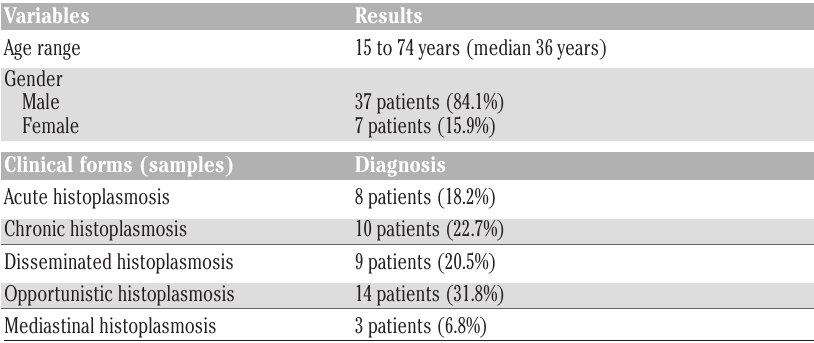
Table 2. Demographic and clinical characteristic of patients with histoplasmosis evaluat- ed in this study.